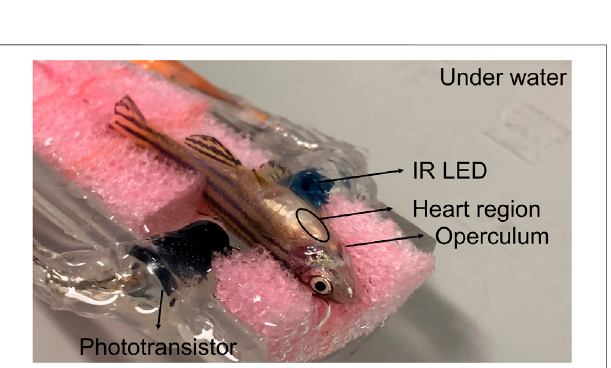
FIGURE3| Zebra fi shinthebedwithaspongetoimproveimmobilization and positioning of zebra fi sh.